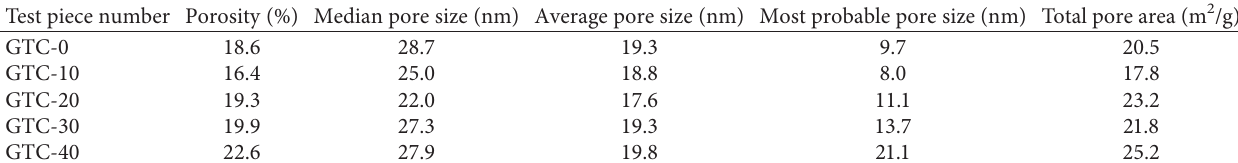
Figure 13: Pore size distribution of GTC (0% to 40%). Table 6: Pore structure characteristics of GTC 0% to